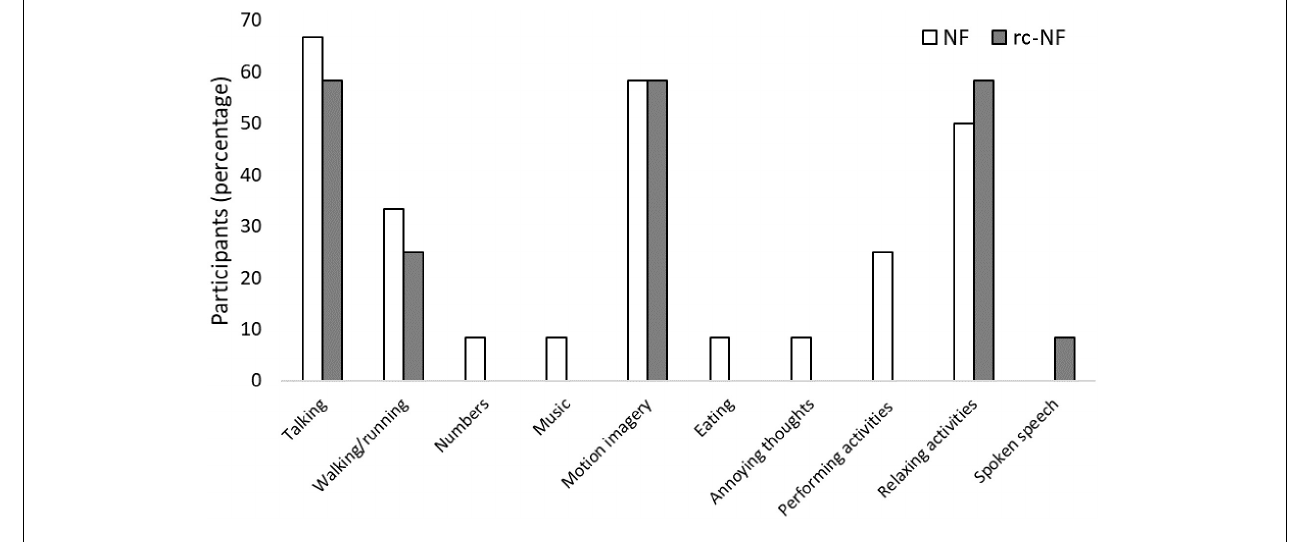
FIGURE 6 | Imagery strategies for NF employed by the participants.